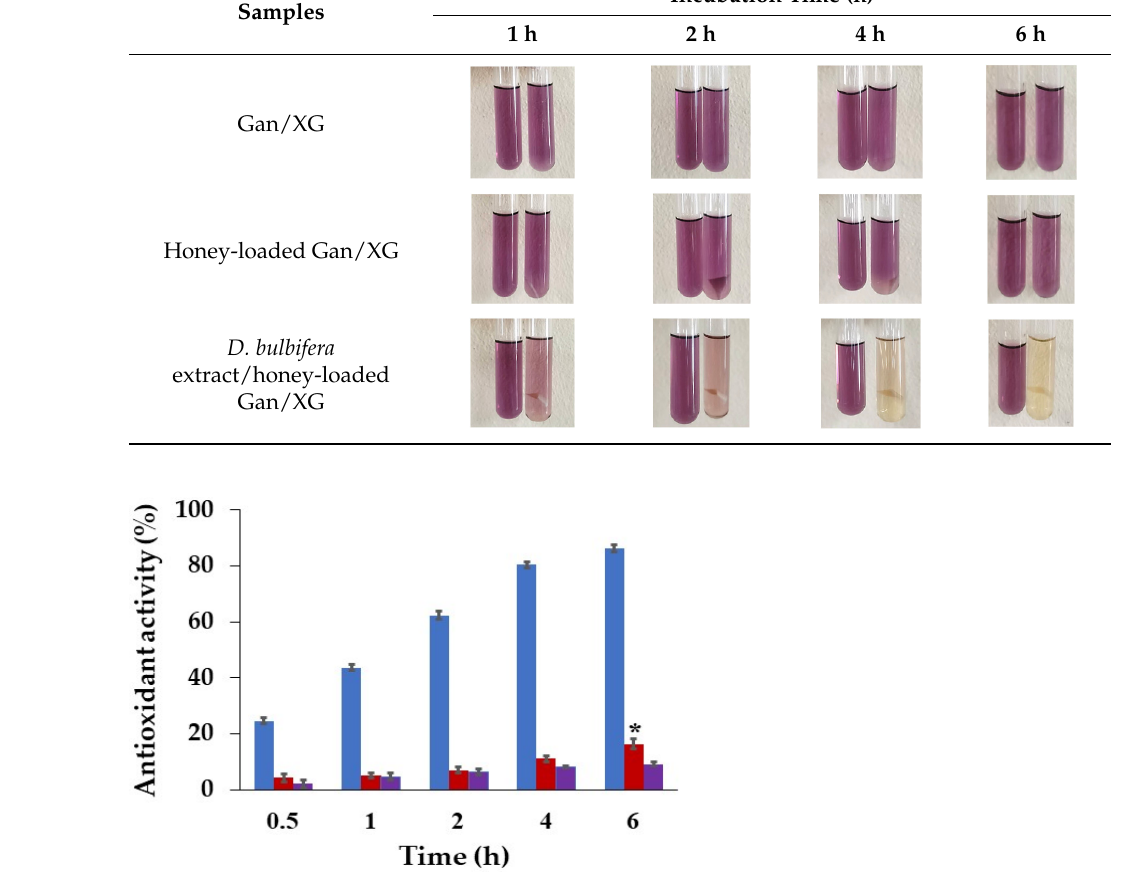
Figure 6. Antioxidant activities of ( ) Gan/XG hydrogel patches, ( Figure 6. Antioxidant activities of (  ) Gan/XG hydrogel patches, (  ) honey-loaded Gan/XG hydro- Figure 6. Antioxidant activities of (  ) Gan/XG hydrogel patches, (  ) honey-loaded Gan/XG hydro- Figure 6. Antioxidant activities of (  ) Gan/XG hydrogel patches, (  ) honey-loaded Gan/XG hydro- Figure 6. Antioxidant activities of (  ) Gan/XG hydrogel patches, (  ) honey-loaded Gan/XG hydro- Figure 6. Antioxidant activities of (  ) Gan/XG hydrogel patches, (  ) honey-loaded Gan/XG hydro- Figure 6. Antioxidant activities of (  ) Gan/XG hydrogel patches, (  ) honey-loaded Gan/XG hydro- Figure 6. Antioxidant activities of (  ) Gan/XG hydrogel patches, (  ) honey-loaded Gan/XG hydro- Figure 6. Antioxidant activities of (  ) Gan/XG hydrogel patches, (  ) honey-loaded Gan/XG hydro- gel patches, and (  ) D. bulbifera extract/honey-loaded Gan/XG hydrogel patches at 0.5, 1, 2, 4, and 6 gel patches, and (  ) D. bulbifera extract/honey-loaded Gan/XG hydrogel patches at 0.5, 1, 2, 4, and 6 ) D. bulbifera extract/honey-loaded Gan/XG hydrogel patches at 0.5, 1, 2, 4, and 6 h. gel patches, and (  ) D. bulbifera extract/honey-loaded Gan/XG hydrogel patches at 0.5, 1, 2, 4, and 6 gel patches, and (  ) D. bulbifera extract/honey-loaded Gan/XG hydrogel patches at 0.5, 1, 2, 4, and 6 gel patches, and (  ) D. bulbifera extract/honey-loaded Gan/XG hydrogel patches at 0.5, 1, 2, 4, and 6 gel patches, and (  ) D. bulbifera extract/honey-loaded Gan/XG hydrogel patches at 0.5, 1, 2, 4, and 6 gel patches, and (  ) D. bulbifera extract/honey-loaded Gan/XG hydrogel patches at 0.5, 1, 2, 4, and 6 gel patches, and (  ) D. bulbifera extract/honey-loaded Gan/XG hydrogel patches at 0.5, 1, 2, 4, and 6 Figure 6. Antioxidant activities of (  ) Gan/XG hydrogel patches, (  ) honey-loaded Gan/XG hydro- Figure 6. Antioxidant activities of (  ) Gan/XG hydrogel patches, (  ) honey-loaded Gan/XG hydro- Figure 6. Antioxidant activities of (  ) Gan/XG hydrogel patches, (  ) honey-loaded Gan/XG hydro- Figure 6. Antioxidant activities of (  ) Gan/XG hydrogel patches, (  ) honey-loaded Gan/XG hydro- h. * p -value < 0.05 of honey-loaded Gan/XG compared with Gan/XG at the same concentration. h. * p -value < 0.05 of honey-loaded Gan/XG compared with Gan/XG at the same concentration. h. * p -value < 0.05 of honey-loaded Gan/XG compared with Gan/XG at the same concentration. * p -value < 0.05 of honey-loaded Gan/XG compared with Gan/XG at the same h. * p -value < 0.05 of honey-loaded Gan/XG compared with Gan/XG at the same concentration. Figure 6. Antioxidant activities of (  ) Gan/XG hydrogel patches, (  ) honey-loaded Gan/XG hydro- Figure 6. Antioxidant activities of (  ) Gan/XG hydrogel patches, (  ) honey-loaded Gan/XG hydro- Figure 6. Antioxidant activities of (  ) Gan/XG hydrogel patches, (  ) honey-loaded Gan/XG hydro- h. * p -value < 0.05 of honey-loaded Gan/XG compared with Gan/XG at the same concentration. h. * p -value < 0.05 of honey-loaded Gan/XG compared with Gan/XG at the same concentration. Figure 6. Antioxidant activities of (  ) Gan/XG hydrogel patches, (  ) honey-loaded Gan/XG hydro- h. * p -value < 0.05 of honey-loaded Gan/XG compared with Gan/XG at the same concentration. h. * p -value < 0.05 of honey-loaded Gan/XG compared with Gan/XG at the same concentration. gel patches, and (  ) D. bulbifera extract/honey-loaded Gan/XG hydrogel patches at 0.5, 1, 2, 4, and 6 gel patches, and (  ) D. bulbifera extract/honey-loaded Gan/XG hydrogel patches at 0.5, 1, 2, 4, and 6 gel patches, and (  ) D. bulbifera extract/honey-loaded Gan/XG hydrogel patches at 0.5, 1, 2, 4, and 6 gel patches, and (  ) D. bulbifera extract/honey-loaded Gan/XG hydrogel patches at 0.5, 1, 2, 4, and 6 gel patches, and (  ) D. bulbifera extract/honey-loaded Gan/XG hydrogel patches at 0.5, 1, 2, 4, and 6 gel patches, and (  ) D. bulbifera extract/honey-loaded Gan/XG hydrogel patches at 0.5, 1, 2, 4, and 6 gel patches, and (  ) D. bulbifera extract/honey-loaded Gan/XG hydrogel patches at 0.5, 1, 2, 4, and 6 gel patches, and (  ) D. bulbifera extract/honey-loaded Gan/XG hydrogel patches at 0.5, 1, 2, 4, and 6 h. * p -value < 0.05 of honey-loaded Gan/XG compared with Gan/XG at the same concentration. h. * p -value < 0.05 of honey-loaded Gan/XG compared with Gan/XG at the same concentration. h. * p -value < 0.05 of honey-loaded Gan/XG compared with Gan/XG at the same concentration. h. * p -value < 0.05 of honey-loaded Gan/XG compared with Gan/XG at the same concentration. h. * p -value < 0.05 of honey-loaded Gan/XG compared with Gan/XG at the same concentration. h. * p -value < 0.05 of honey-loaded Gan/XG compared with Gan/XG at the same concentration. h. * p -value < 0.05 of honey-loaded Gan/XG compared with Gan/XG at the same concentration. h. * p -value < 0.05 of honey-loaded Gan/XG compared with Gan/XG at the same concentration.